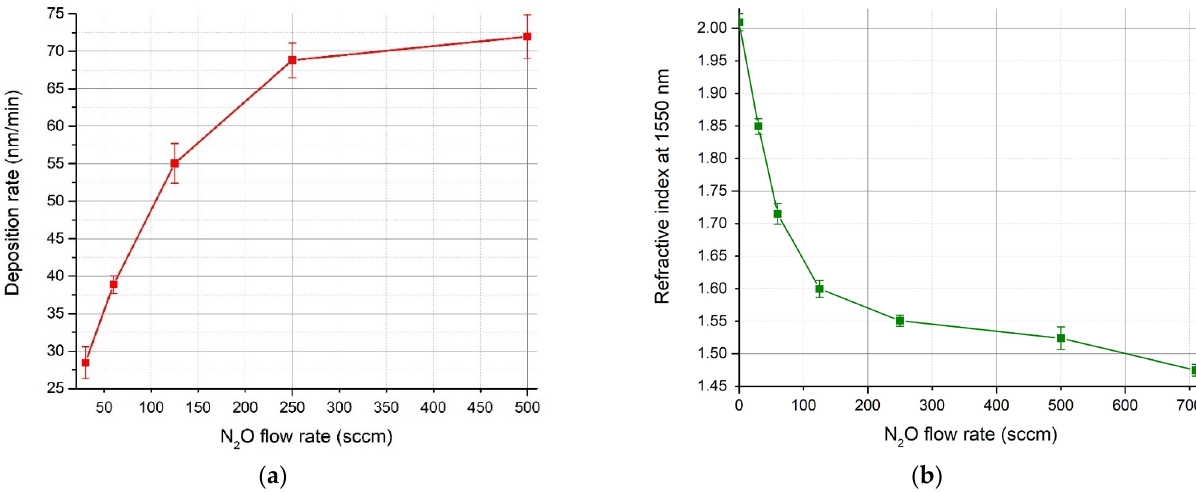
Figure 2. ( a ) Deposition rate (nm/min) of the SiON film deposited by the PECVD technique as a function of N 2 O flow rate; ( b ) the dependence of the refractive index of SiON, SiN, SiO x films at a wavelength λ = 1550 nm on a N 2 O flow rate.